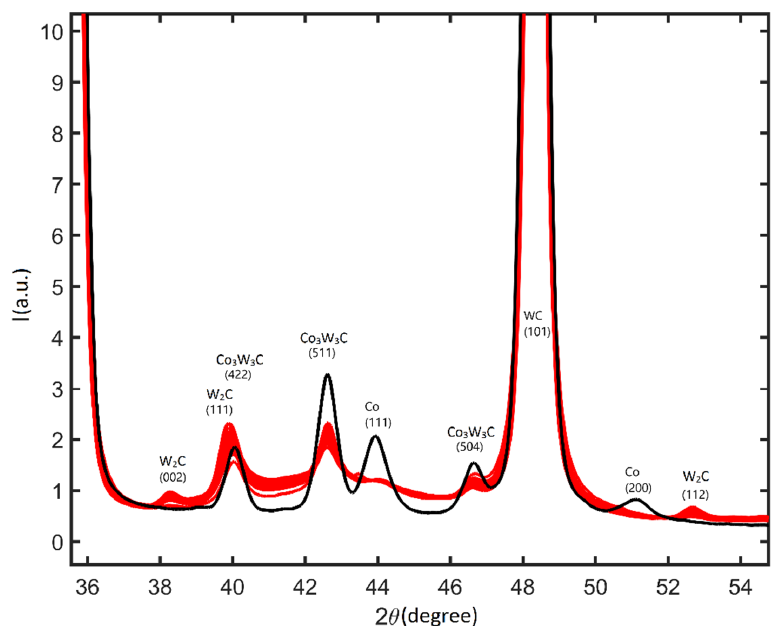
Figure 2. XRD patterns obtained from the WC-CoCr feedstock and 29 produced WC-CoCr coatings. Compared to the feedstock (black curve), the coatings (red curves) show a varying proportion of eta phases and W 2 C, while the cobalt proportion decreases significantly. Table 2 summarizes the factor levels of the independent variables, as well as the cor- responding results for the response variable, i.e., W 2 C to WC ratio, taken from the peak analyses. The statistical design allows us to estimate the linear (L) and quadratic (Q) ef- fects, and also the interactions (int.) between the variables. Table 2. Level settings of the independent variables examined in the CCD with additional center run, and the corresponding response variable (mean values).